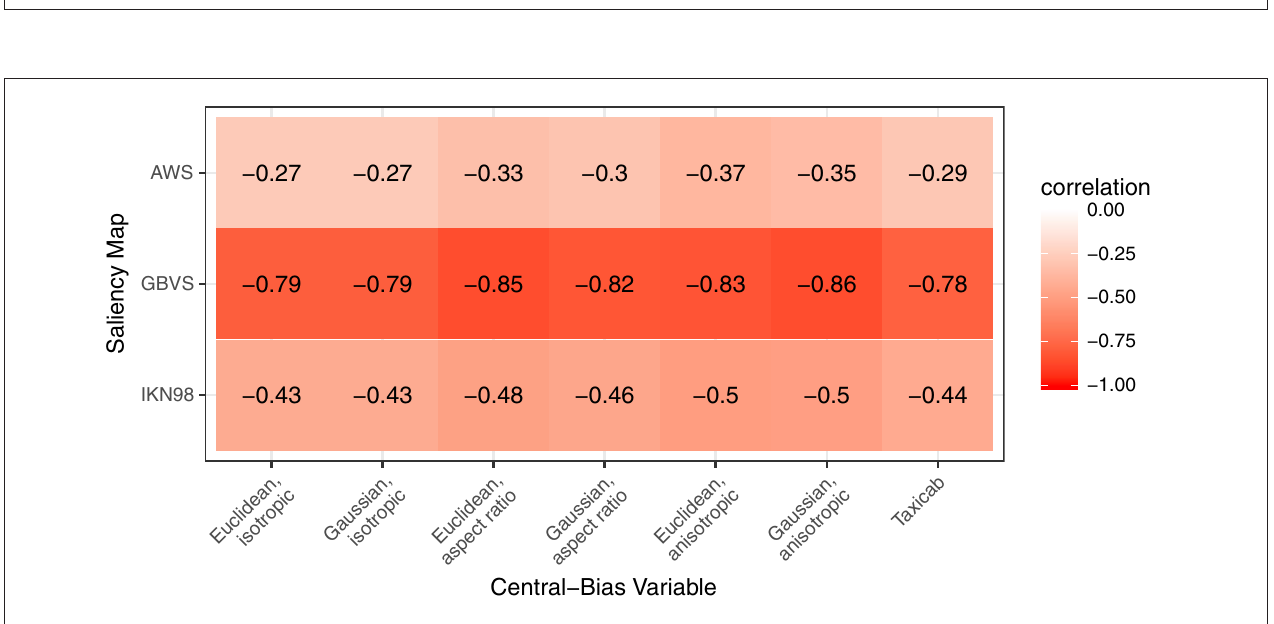
FIGURE 5 | Pairwise correlation between saliency and distance from center for three different saliency maps (rows) and seven different central-bias variables (columns). Correlations are strongest for GBVS.